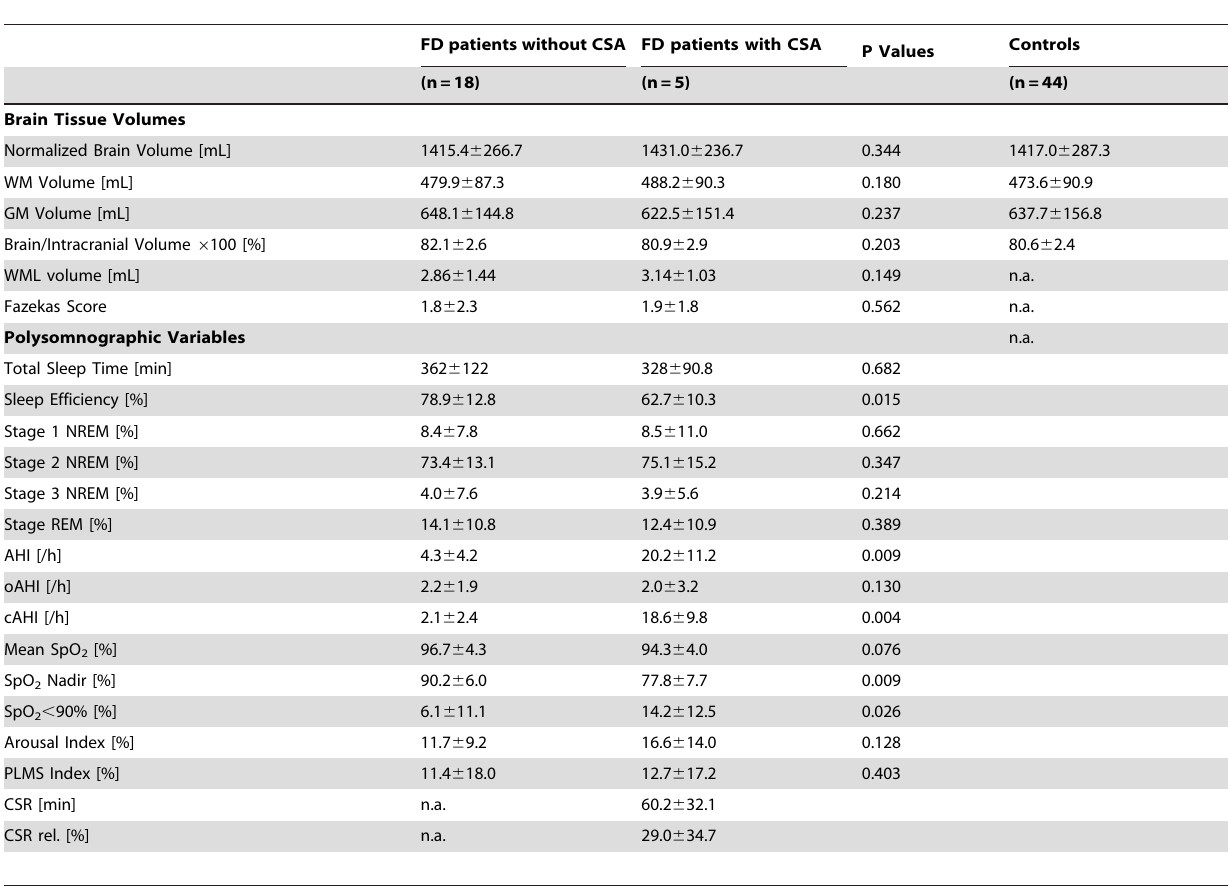
Table 2. Means and Standard Deviations of the MR imaging analyses and polysomnographic parameter.